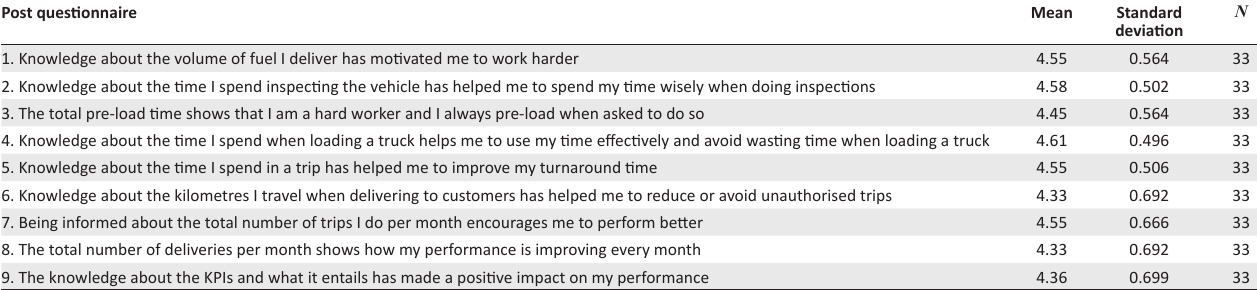
TABLE 2: Impact of key performance indicators. Post questionnaire